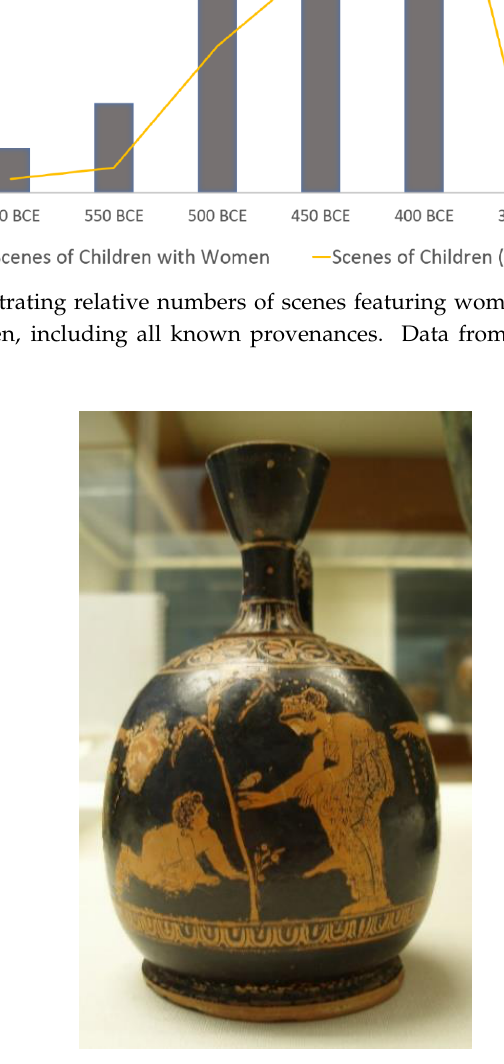
Figure 14. Athenian red-figure squat lekythos showing women and a child in a garden, attributed to the manner of the Meidias Painter. 420–400 BCE. Vase from Athens. London, British Museum 1895,1029.2, BAPD 220621. Credit: Image provided by the British Museum © Trustees of the British Museum.